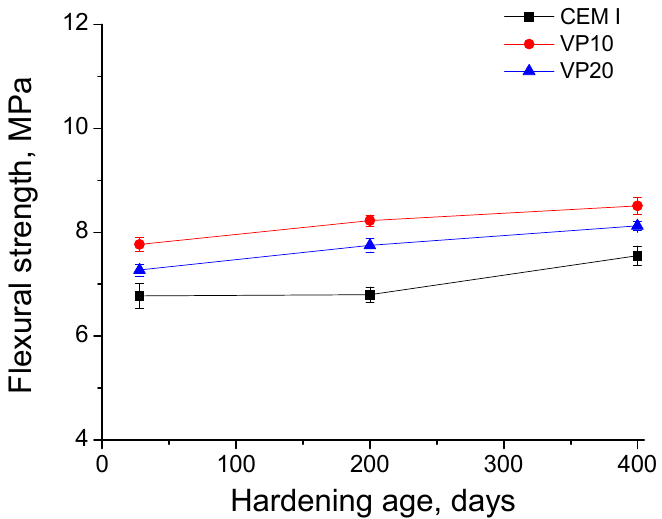
Figure 16. Results of compressive strength for the mortars studied.